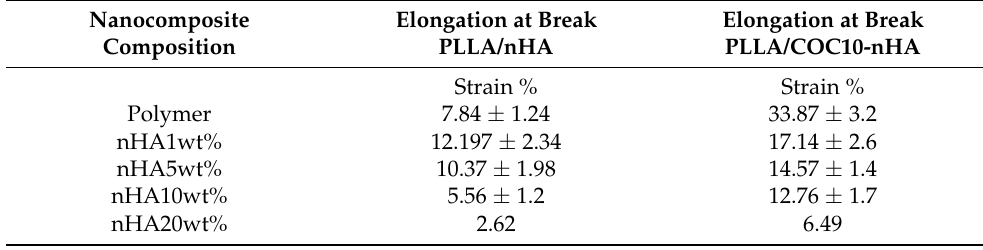
Table 3. Presenting the strain % of PLLA/COC/10-nHA and PLLA-nHA nanocomposites.